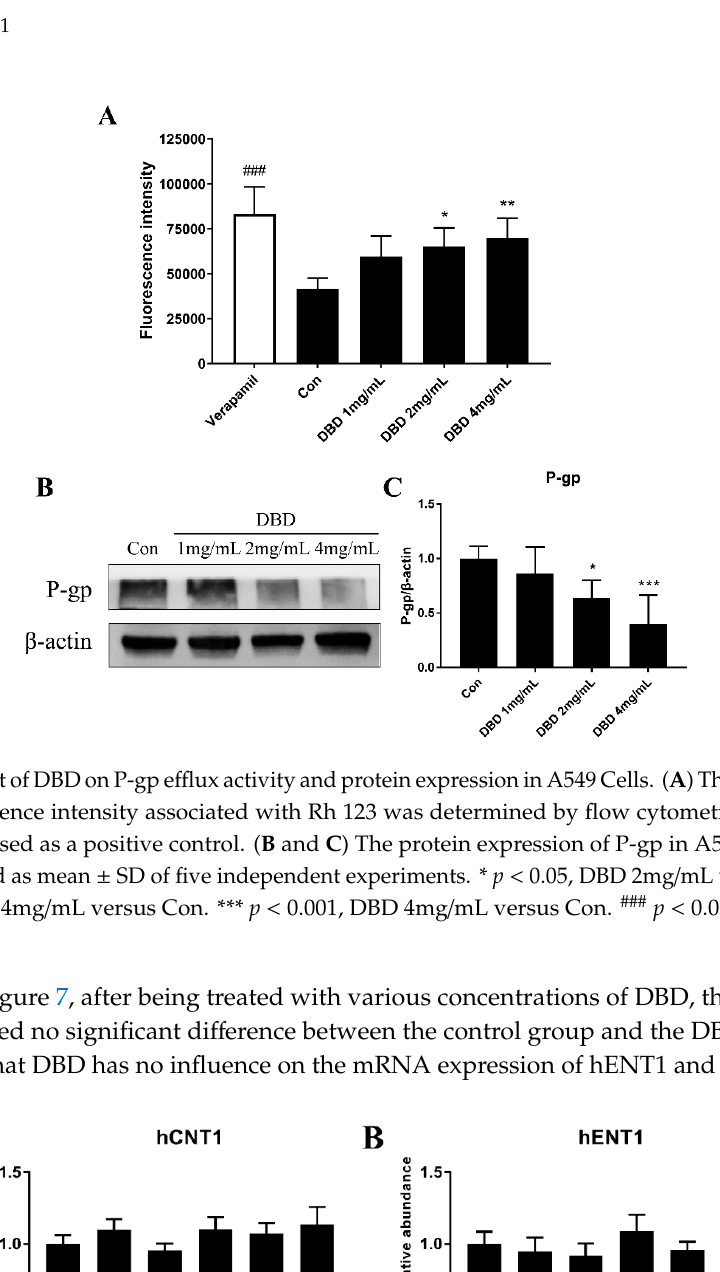
6 of 14 Figure 5. Immune regulatory effect of DBD on LLC-bearing mice. ELISA results showing IL-2 ( A ), IL- 12 ( B ) and GM-CSF ( C ) expression in LLC tumor-bearing mice serum. ( D ) Spleen indexes and ( E ) Thymus indexes of tumor-bearing mice. Data were expressed as mean ± SEM ( n = 4 for A, B, and C. n = 10 for D and E). * p < 0.05, GEM + DBD versus GEM. ** p < 0.01, GEM + DBD versus GEM. ### p < 0.001, GEM versus Con.